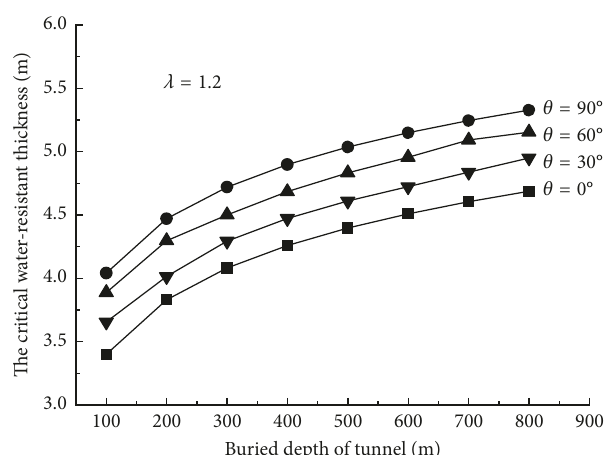
Figure 4: Relationship between the critical water-resistant thick- ness and buried depth of tunnel.